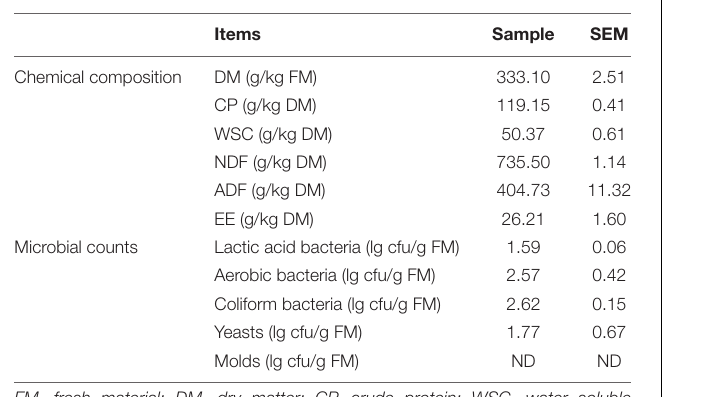
TABLE 1 | Chemical and microbial compositions of fresh Leymus chinensis .